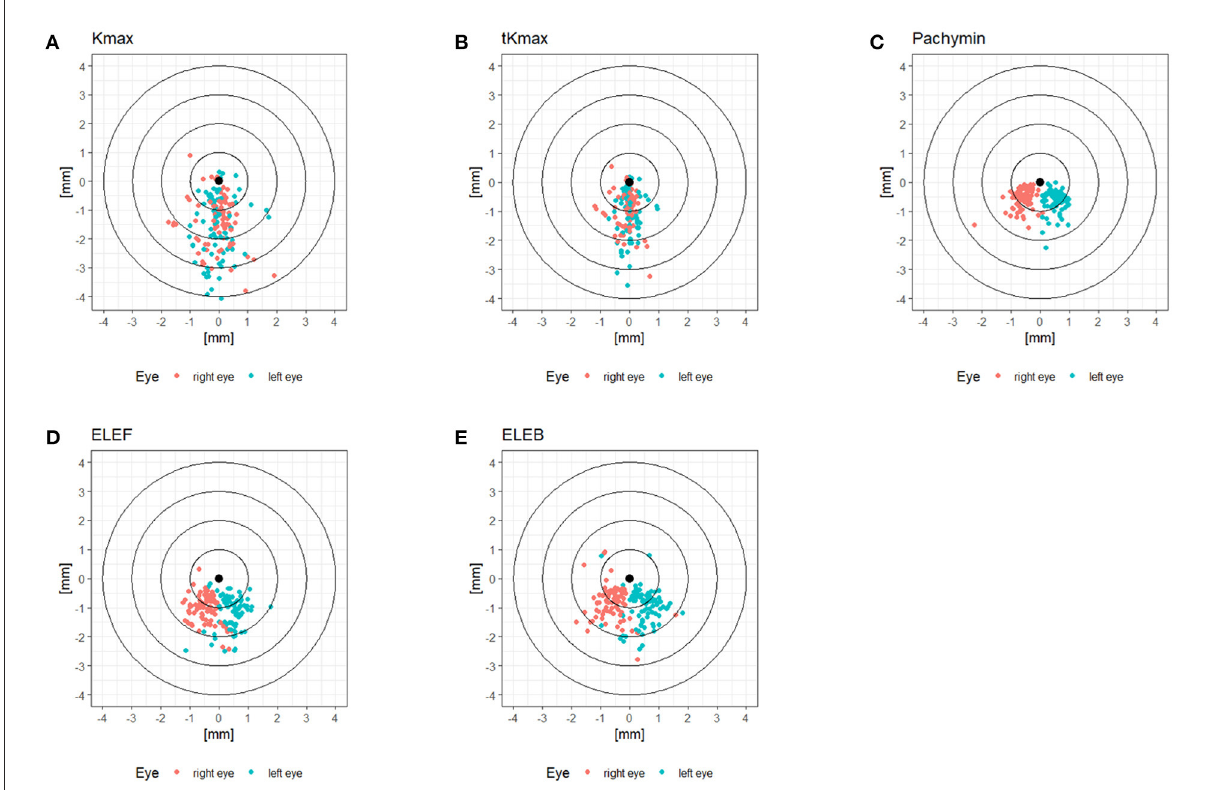
FIGURE1 (A–E) Locations of tomographic parameters relative to the corneal